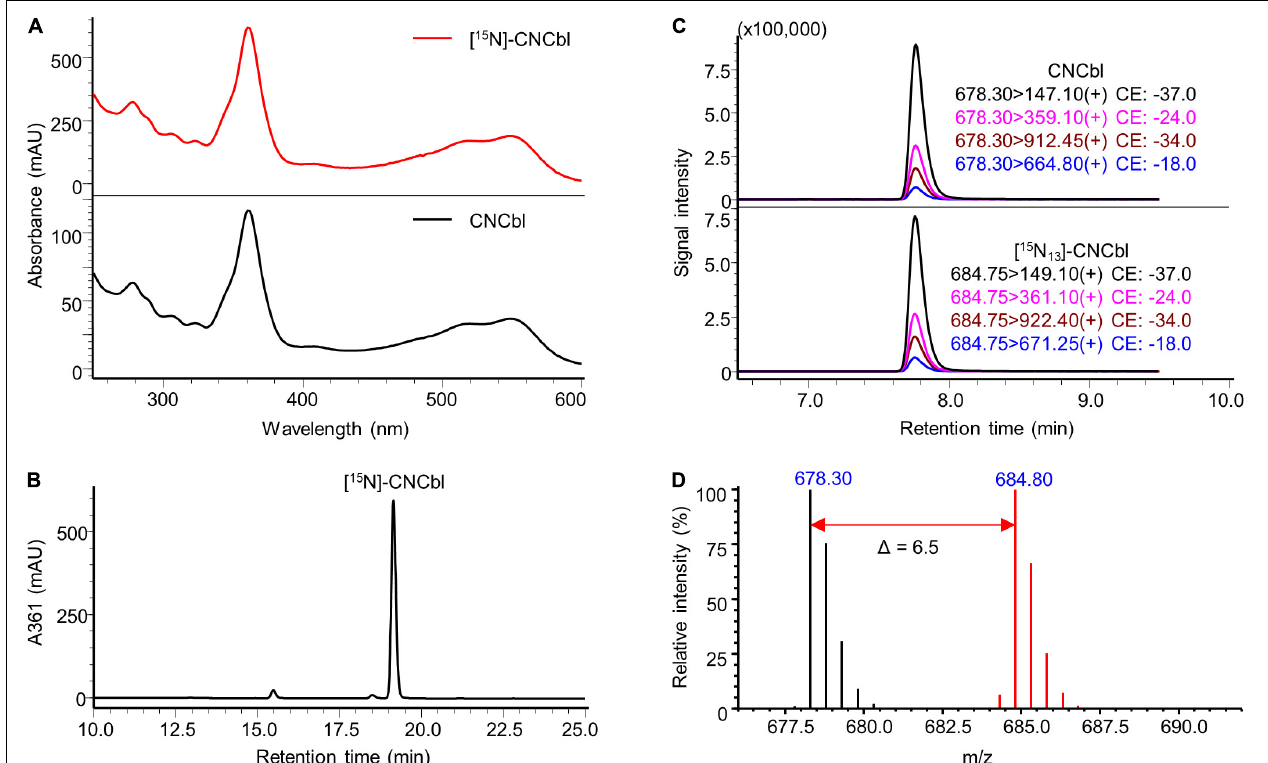
FIGURE 5 | Characterisation of prepared [ 15 N]-CNCbl. (A) UV-Vis spectrum of the prepared [ 15 N]-CNCbl in comparison to that of the CNCbl standard. (B) Preparative HPLC-DAD at a wavelength of 361 nm of the product from cyanidation reaction showed a major peak of [ 15 N]-CNCbl, which has an identical retention time to that of the CNCbl standard under the same elution conditions (see Supplementary Figure 7 ). (C) LC-MS/MS analysis of [ 15 N]-CNCbl monitoring mass transitions corresponding to [ 15 N 13 ]-CNCbl (lower trace). The LC-MS/MS chromatogram of unlabelled CNCbl is shown as a reference (upper trace). (D) Overlaid mass spectra of [ 15 N]-labelled CNCbl (red) and unlabelled CNCbl (black). The mass shift in [M + 2H] 2 + values indicated by the red arrow confirmed the labelling of 13 nitrogen atoms. MS spectra were acquired in selected ion monitoring (SIM) mode with a m/z interval of 0.5.